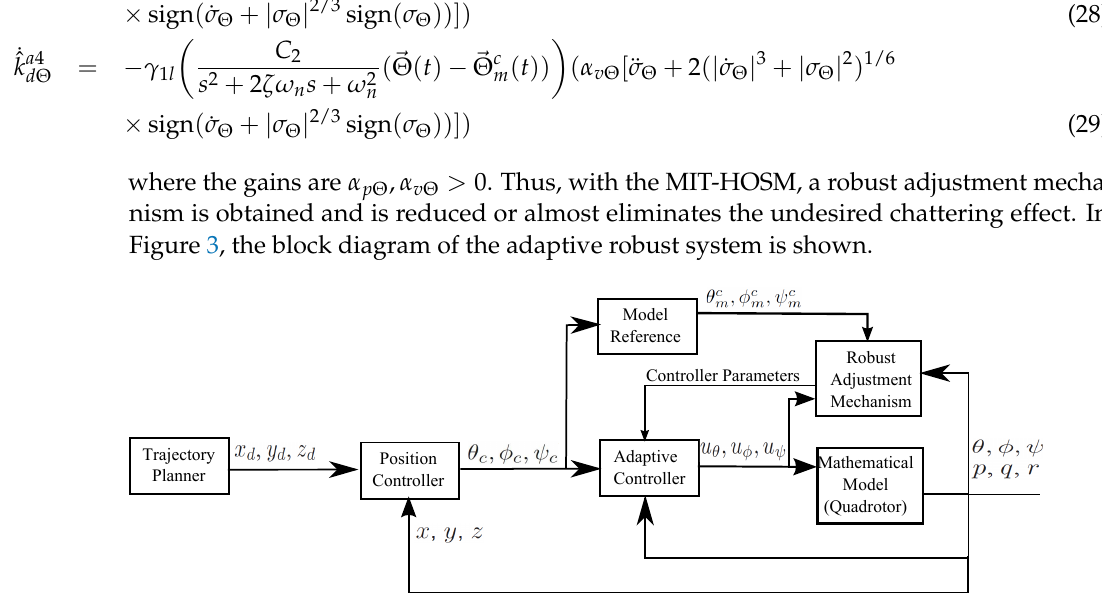
Figure 3. Robust adaptive control